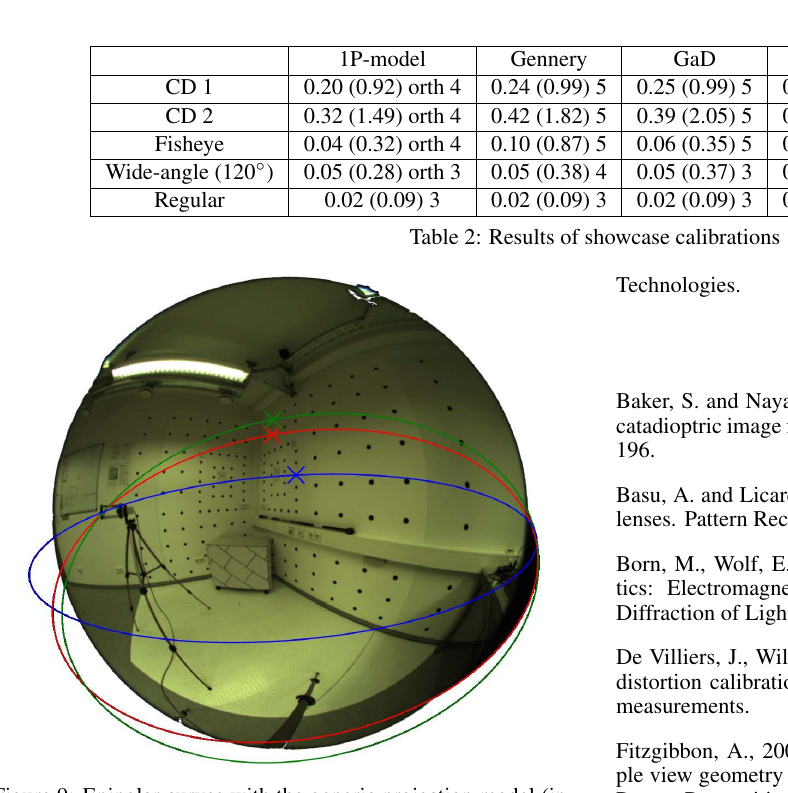
Figure 9: Epipolar curves with the generic projection model (in- tersection as